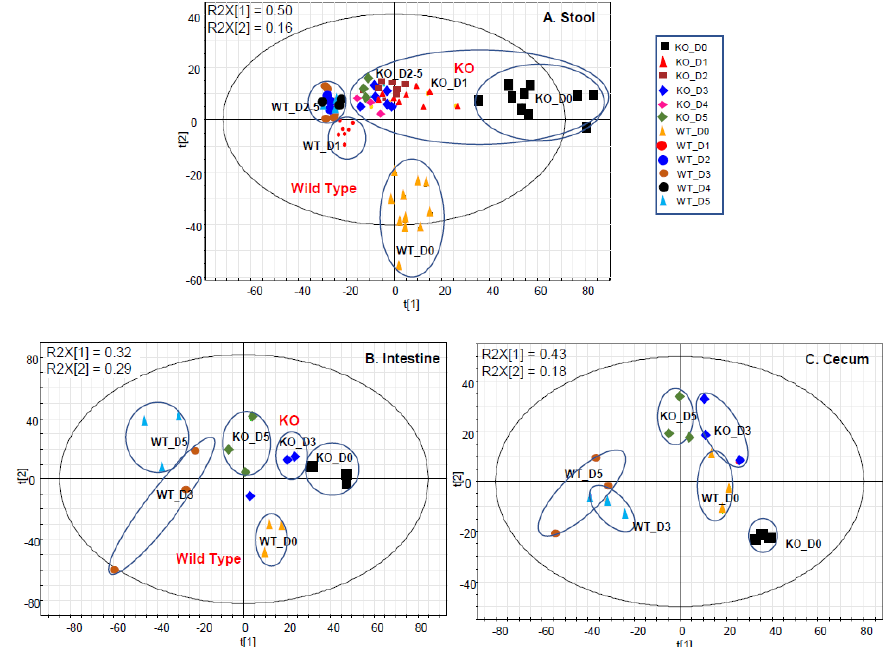
Figure 1. The PLS-DA score plots for stool ( A ) at D0 (control), D1, D2, D3, D4, and D5; and the small intestinal content ( B ) and cecal content ( C ) at D0 (control), D3, and D5. KO indicates the knock-out mice and WT indicates wild type.